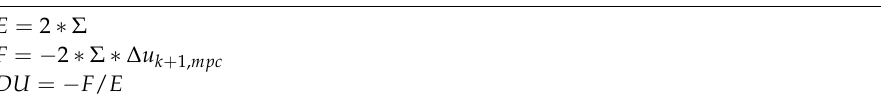
Algorithm 11: Compute the unconstrained solution for